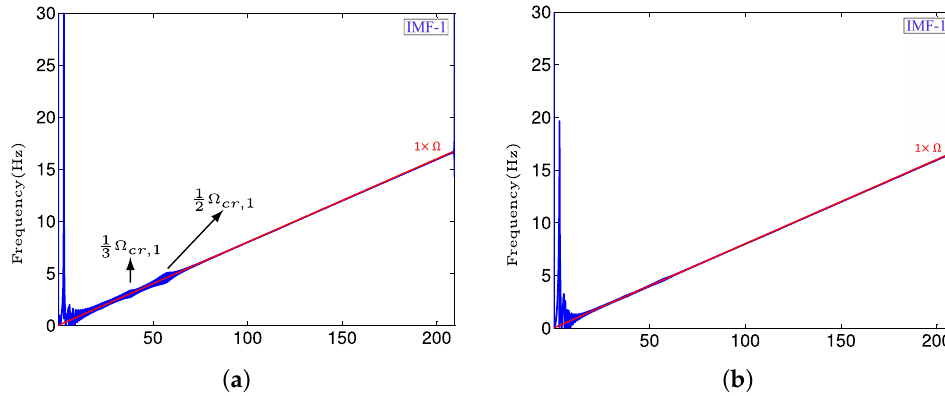
Figure 11. Time–frequency representations of the vertical transient response of the system with a small crack, ( µ = 0.2 ) using HHT based on ( a ) improved EMD and ( b ) EMD